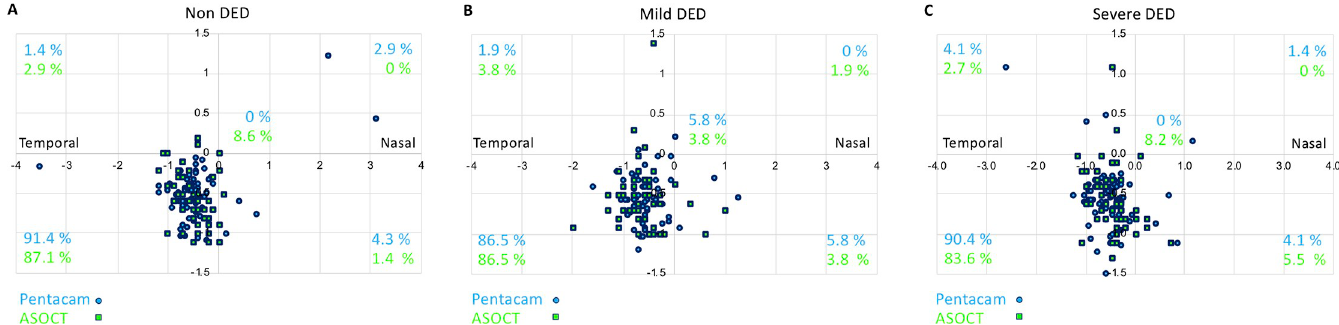
Fig 3. Location of the thinnest point of the cornea as measured by Pentacam and ASOCT. The location of the thinnest point of the cornea was mapped from its quadrant location using Pentacam and ASOCT based on the ( A ) non-DED group, ( B ) mild-DED group, and ( C ) severe-DED group. DED: dry eye disease, ASOCT: anterior segment optical coherence